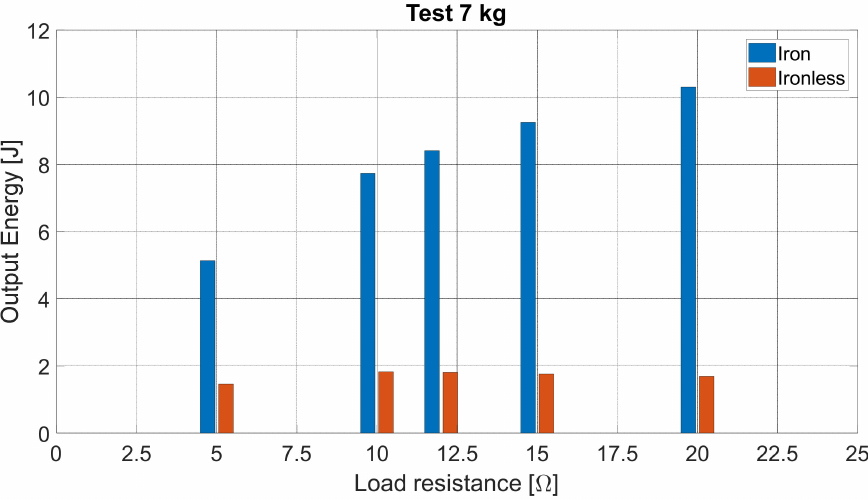
Figure 20. Energy transferred to the electric loads at 7 kg by the two PMLG